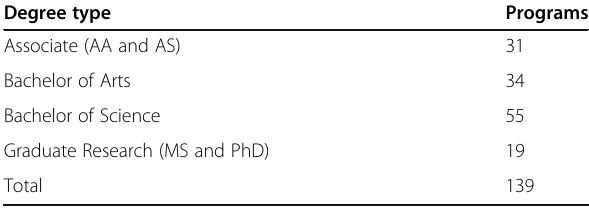
Table 2 Program webpage types included in our